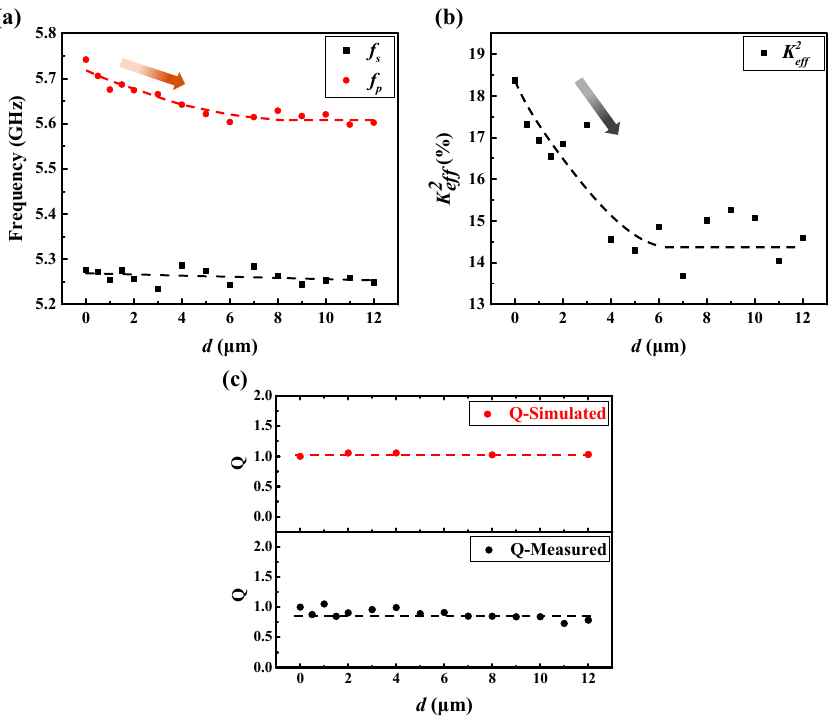
Figure 5. ( a ) The detailed frequency change of measured results with different distance d. ( b ) The calculated K 2 . ( c ) The normalized Q values of FBARs with different distances d.